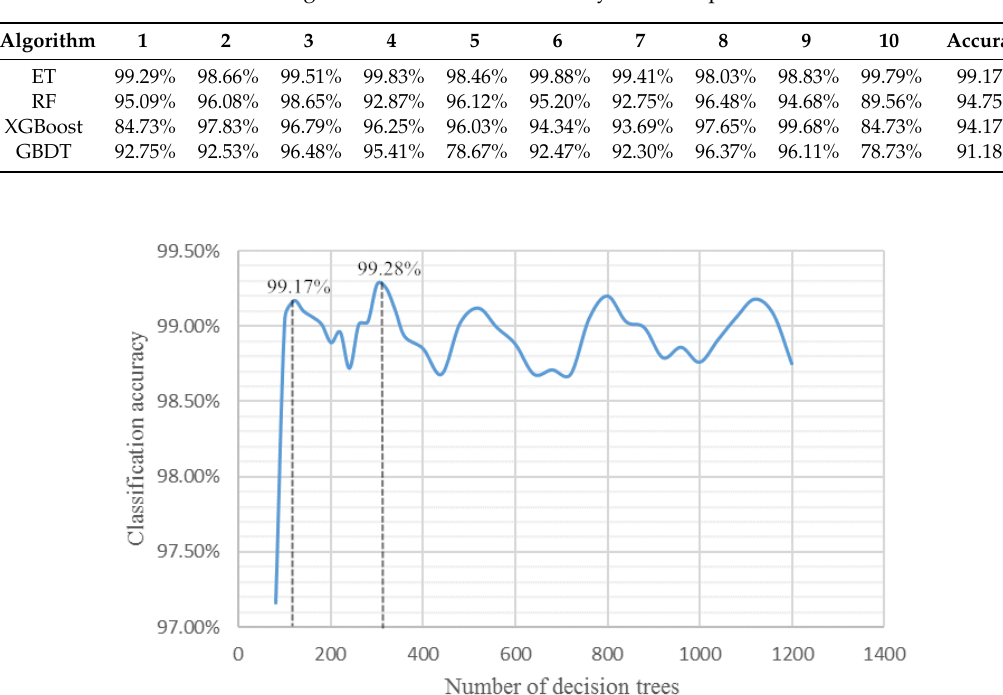
Figure 11. Decision tree number and classification accuracy.